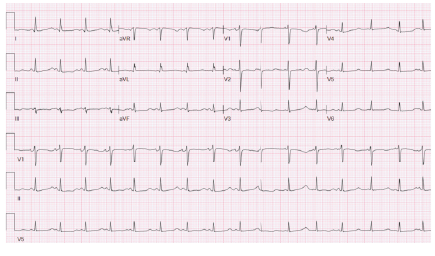
Figure 1: QTc 441 (Day 1). Figure 2: QTc 632 (Day 8).